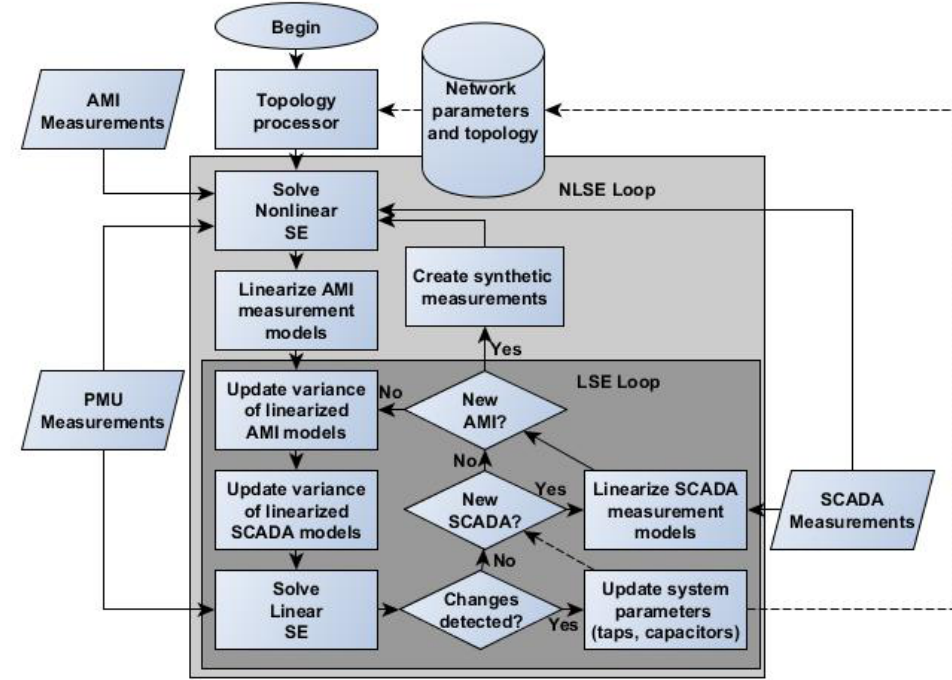
Figure 1. Flowchart showing the µ PMU-Enhanced DSSE gross error analysis